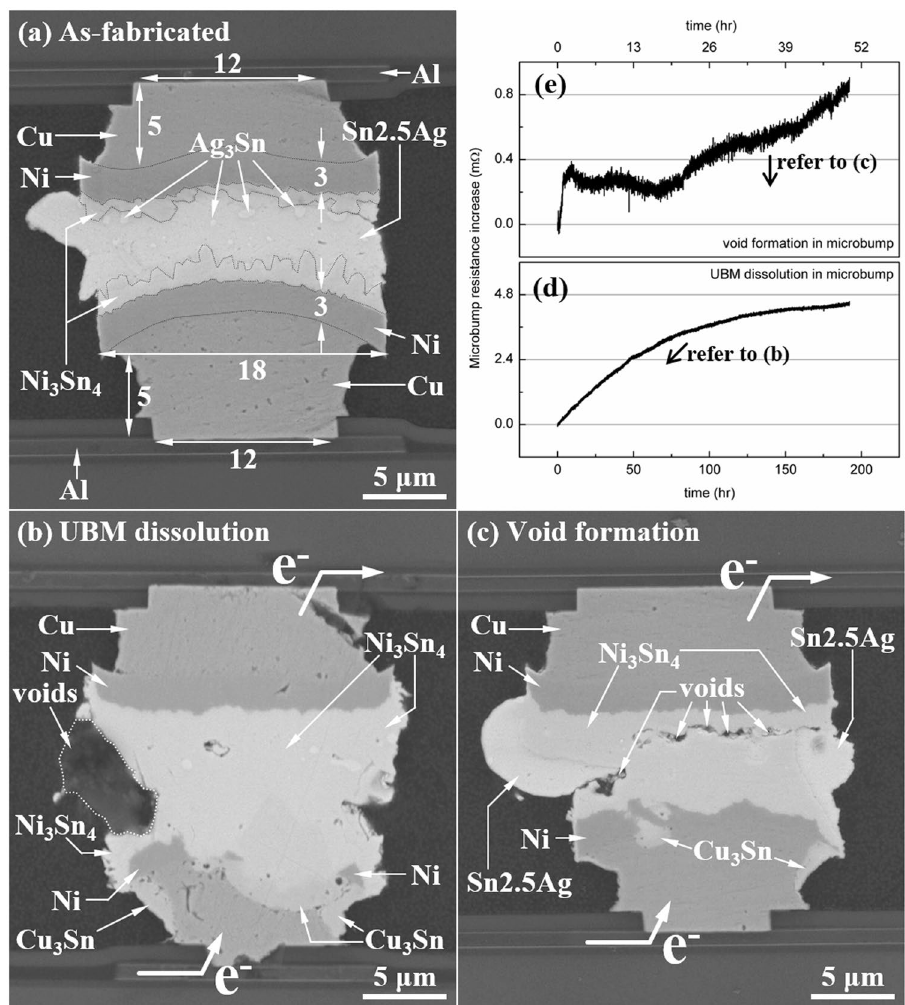
Figure 1. ( a ) The SEM image of the as-fabricated 18 µ m microbump; The SEM image showing ( b ) the UBM dissolution and ( c ) the void formation induced by EM after 9.2 × 10 4 A/cm 2 at 150 °C for 192.3 and 50.0 h, respectively; The resistance increase due to ( d ) the UBM dissolution in ( b ), and ( e ) the void formation in ( e